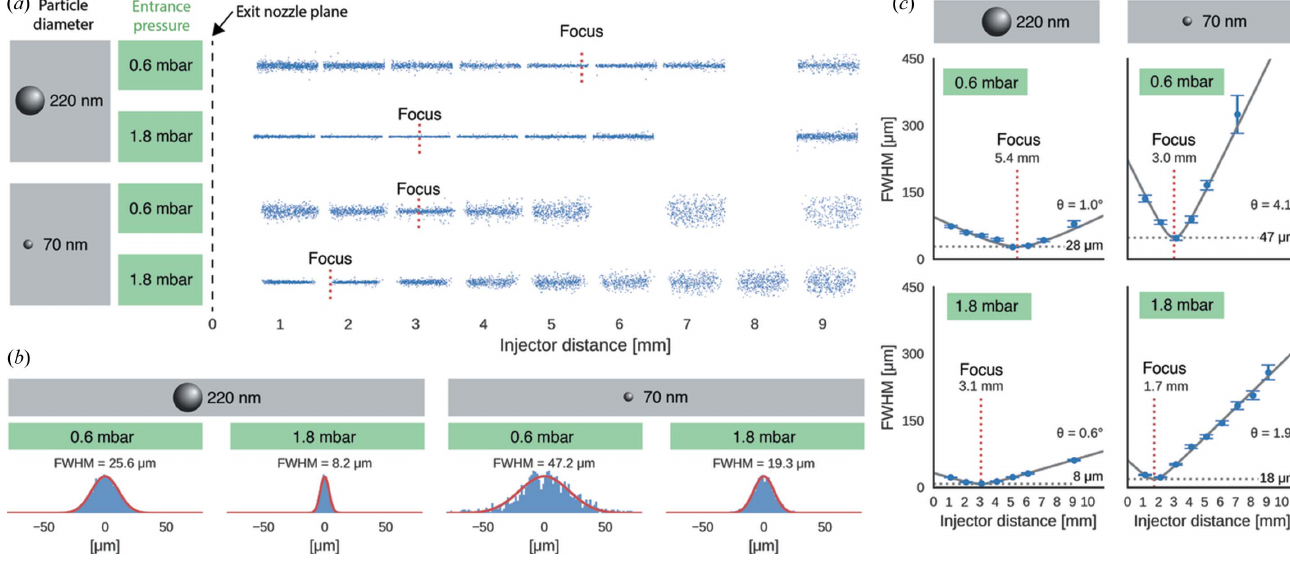
Figure 3 Particle-beam focusing as function of entrance pressure and particle diameter. ( a ) Blue dots represent measured particle positions of injected polystyrene spheres (70 nm and 220 nm in diameter) at entrance pressures of 0.6 mbar and 1.8 mbar, respectively. Gaps are a result of combining the data from measurements at fixed injector distances without overlap of the fields of view. The positions of the focus planes are indicated by dotted red lines. ( b ) Measured particle-beam profiles (blue histograms) in the particle-focus plane were approximated by Gaussian functions (red lines). ( c ) The evolution of the particle-beam width (blue circles) was approximated with a Gaussian-beam model (black solid lines). The model is parameterized by a divergence angle (cid:6) , the beam waist (gray dashed lines) and the position of the focus plane (red dotted